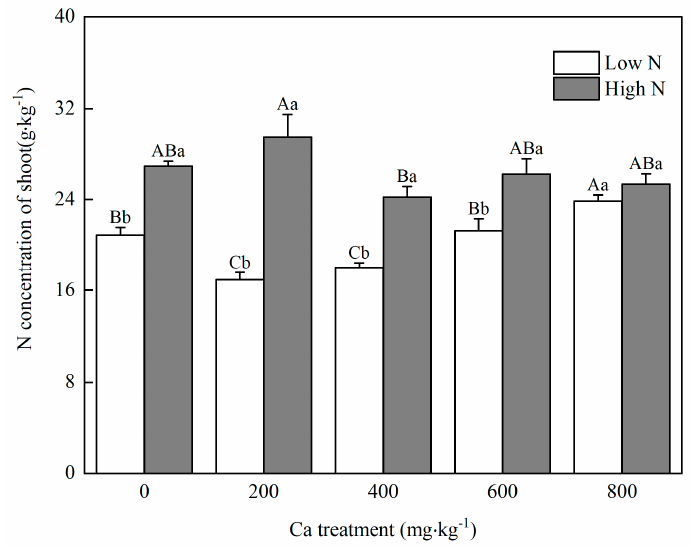
Figure 3. Effect of Ca treatments on the N concentration in shoots under different N levels. Capital letters denote significant differences among different Ca treatments within the same N level. Lowercase letters denote significant differences between the different N levels within the same Ca treatment.